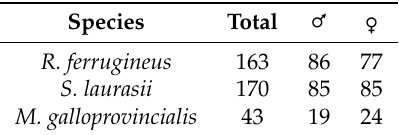
Table 1. Number of individuals collected for each insect